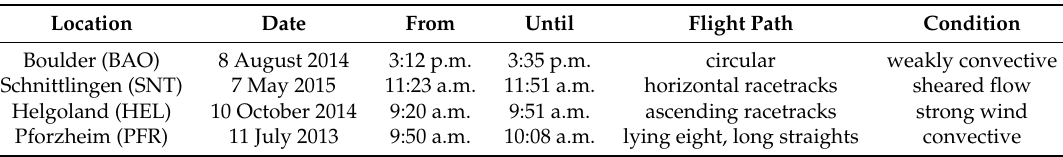
Table 1. Flight sections with location, date, and duration in local time, pattern, and brief atmospheric